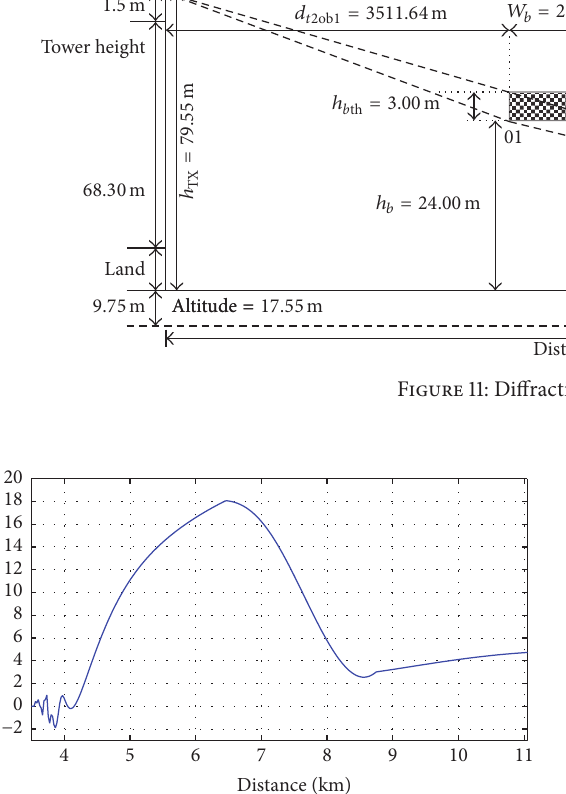
Figure 14: Diffraction loss caused by obstacle 1 in measurement 2.